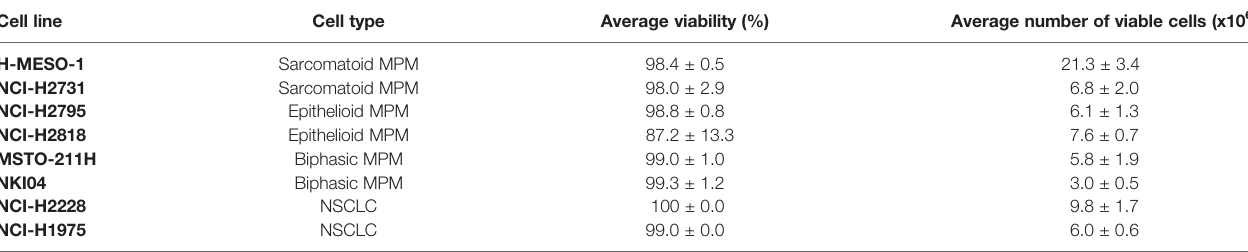
TABLE 1 | Average cell viability (%) and number of viable cells (x10 6 ) of the replicates of the different cell lines after 48 hours of incubation [n=5, except for NKI04 (n=3), NCI-H2228 (n=3) and NCI-H1975 (n=2)]. Cell